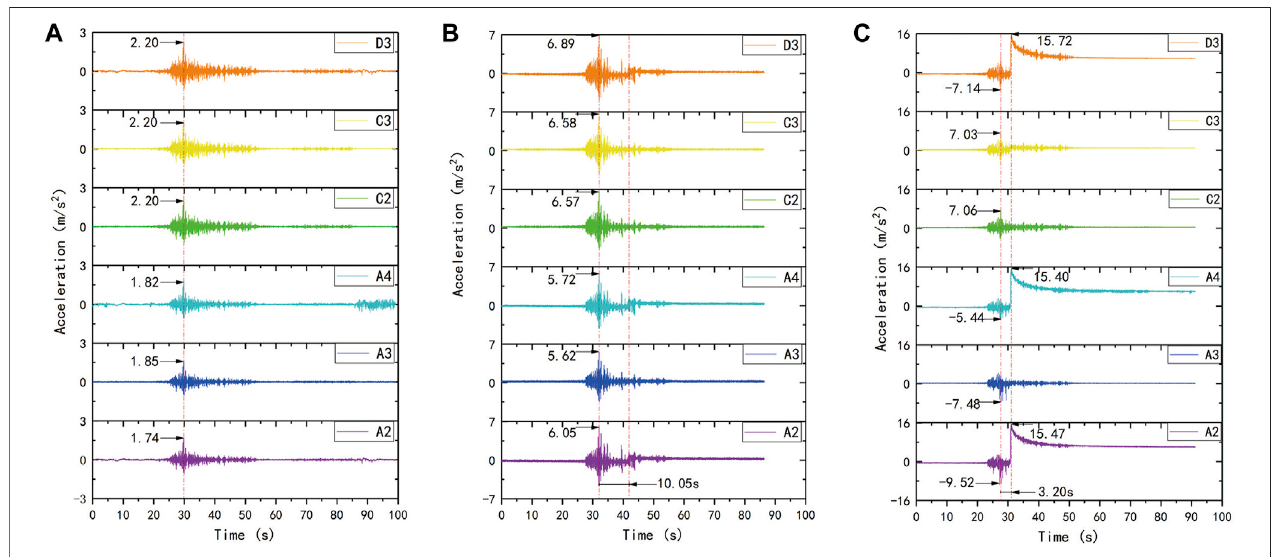
FIGURE 5 | The acceleration time history in the slope. (A) The input amplitude is 113 gal. (B) The input amplitude is 339 gal. (C) The input amplitude is 565 gal.